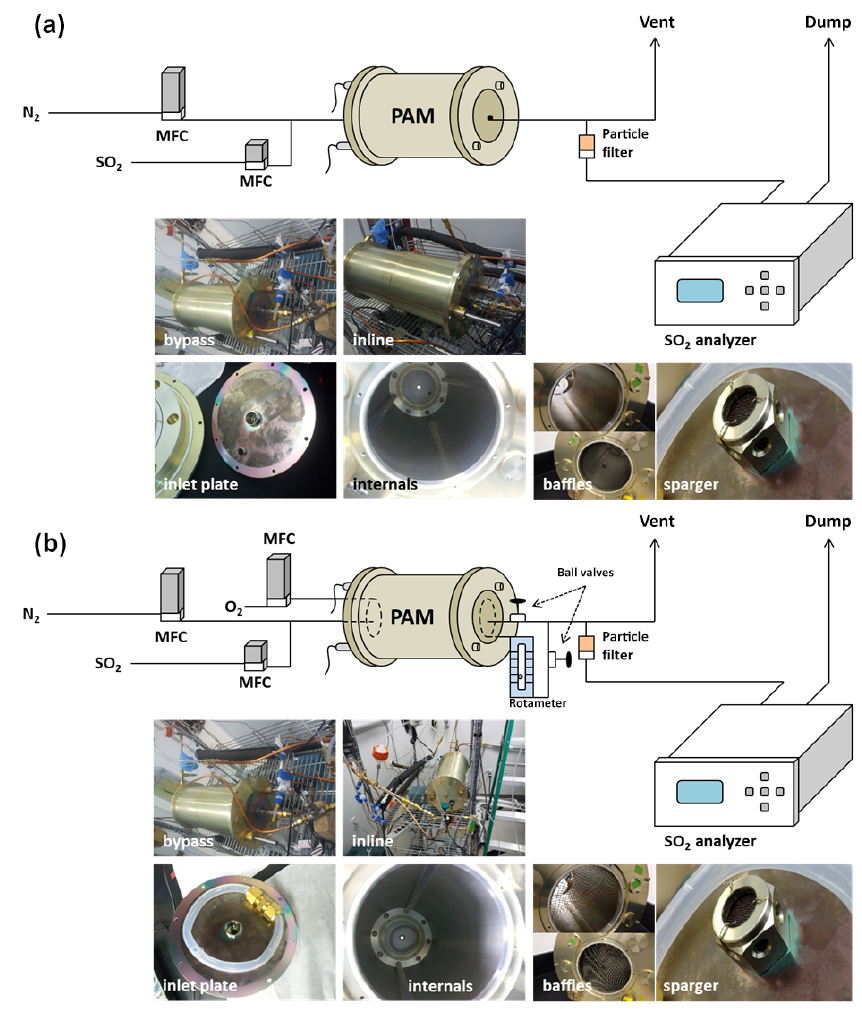
Figure 1. Experimental setup for tracer studies for (a) one inlet and one outlet and (b) peripheral inlets and outlets. The main difference is the presence of the ring sparger in (b)